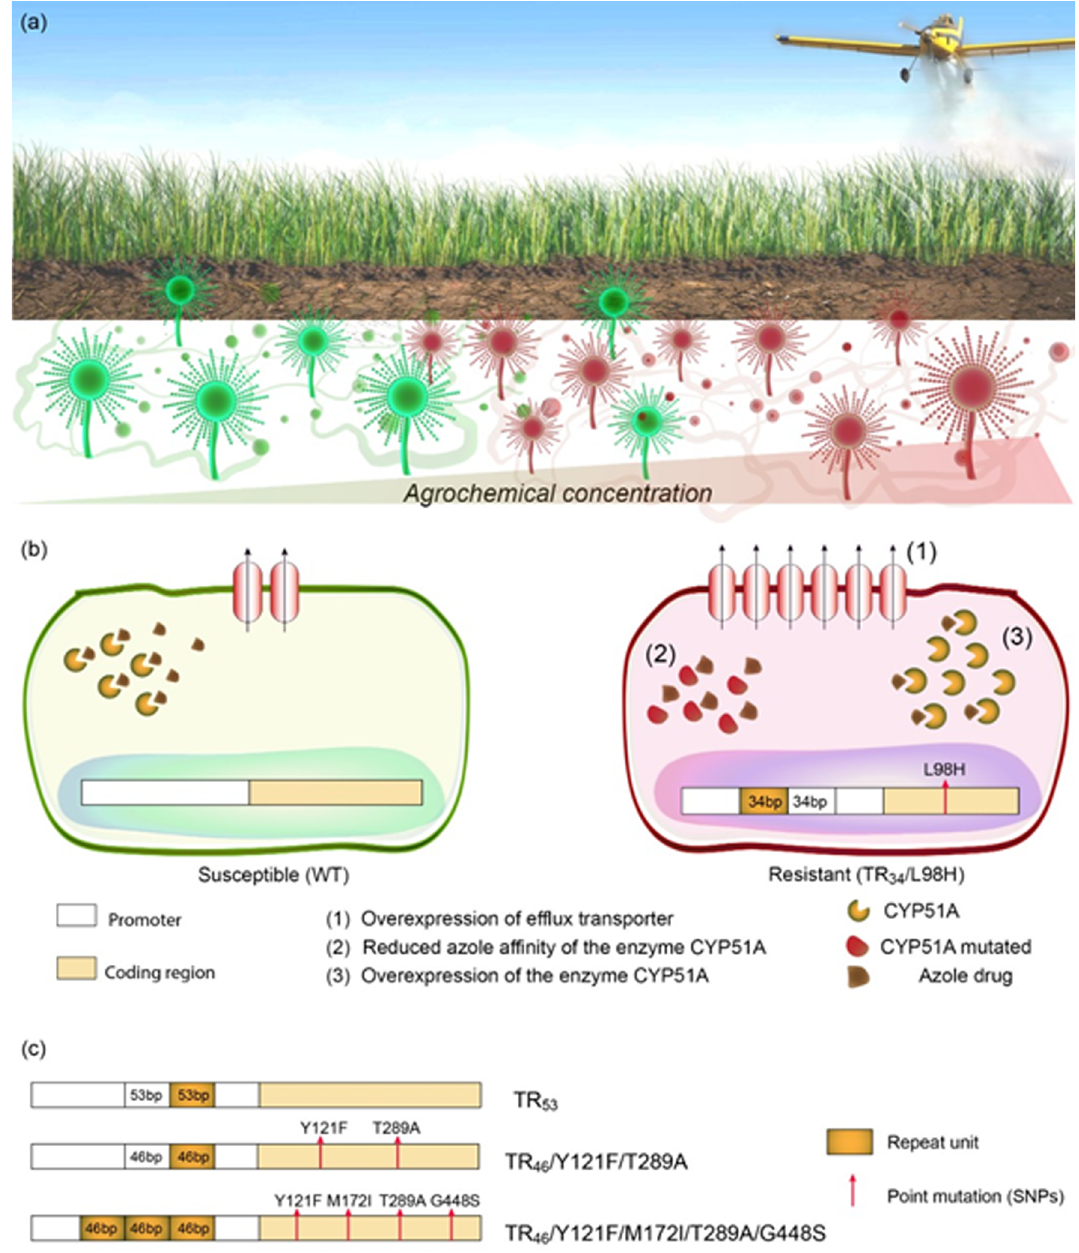
Fig 1. Fungicide exposure effects on Aspergillus fumigatus . (a) Azole-susceptible and azole-resistant A . fumigatus can be identified in both fungicide-free and fungicide-containing soils and plant-based materials. There is an enrichment, however, of azole-resistant A . fumigatus in niches containing fungicides. (b) Azole-resistant A . fumigatus isolated from places holding fungicides may present some alterations compared to susceptible isolates that confer them cross-resistance with medical azoles, such as overexpression of efflux pumps and the azole-target enzyme, CYP51A, and CYP51A with a reduced azole affinity. The last 2 physiological changes are due to mutations in the gene cyp51A . The most common mutations are a pair of 34-bp sequence (in tandem) in the gene promoter (TR 34 ), which lead to overexpression of cyp51A , together with a mutation that results in leucine replacement by histidine at position 98 (L98H) in the enzyme CYP51A, reducing the affinity of the enzyme to the azole drugs. (c) Other tandem repeat mutations combined or not with point mutations in the gene cyp51A conferring cross-resistance between environmental and medical azoles also can be detected in azole-resistant A . fumigatus isolated from fungicides-containing places. It AU : PleaseconfirmthattheeditstothesentenceItisimportanttonoticethatthealterationsrepresentedcorrespond ::: didnotaltertheintendedthoughtofthesentence : is important to notice that the alterations represented correspond to amino acids and not in the DNA and that other tandem repeat mutations have already been observed in the clinical sets, but only TR 34 , TR 46 , and TR 53 have been describing in environmental strains.